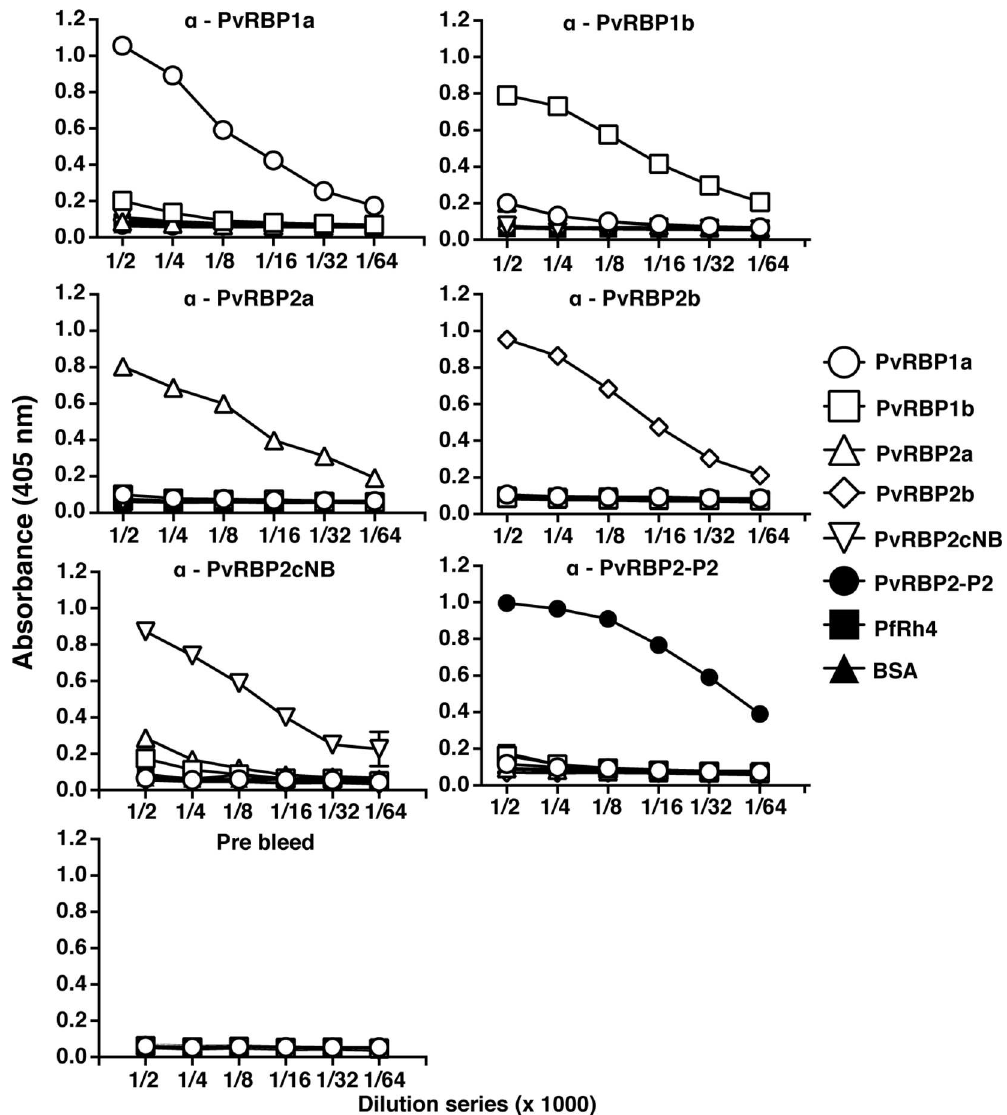
Fig 2. Detectionof PvRBPs by rabbitanti-PvRBPpolyclonal antibodiesby ELISA. Microtiter wells were coatedwith each PvRBP per well as shown by symbols on the left. Solid lines show specific anti-PvRBPs polyclonalantibodies(top label)added to each plate in a dilutionseries.The opticaldensity (OD)was measuredat 405 nm. MeanOD values fromduplicatedwells and standarddeviation are shown.